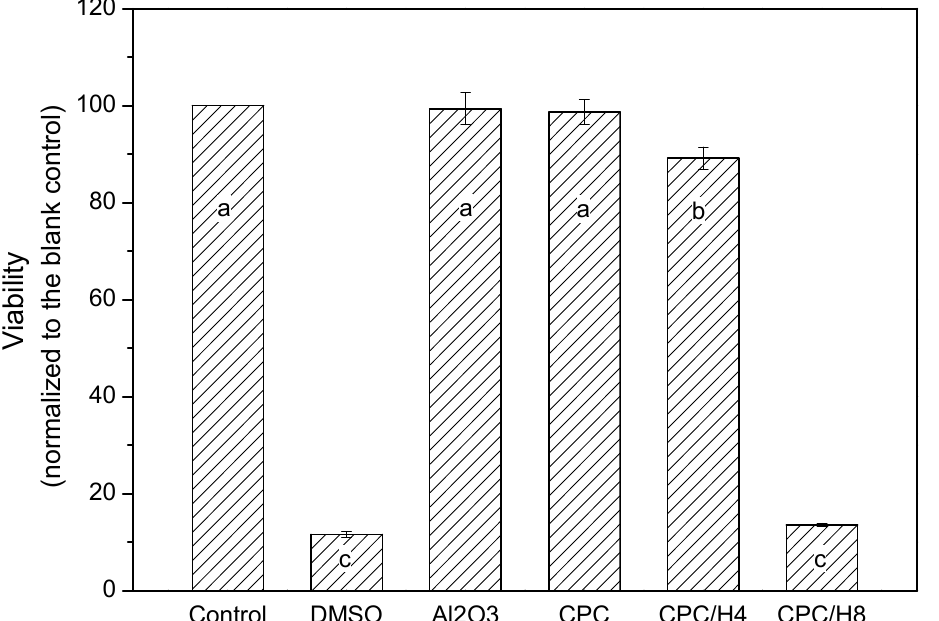
Figure 4. Cytotoxicity test (24 h) of CPC, CPC/H4 and CPC/H8 compare to the positive control (10% DMSO) and blank control (Al 2 O 3 ). The data in the same statistical level was marked with the same letter (a, b, and c) on the bar.